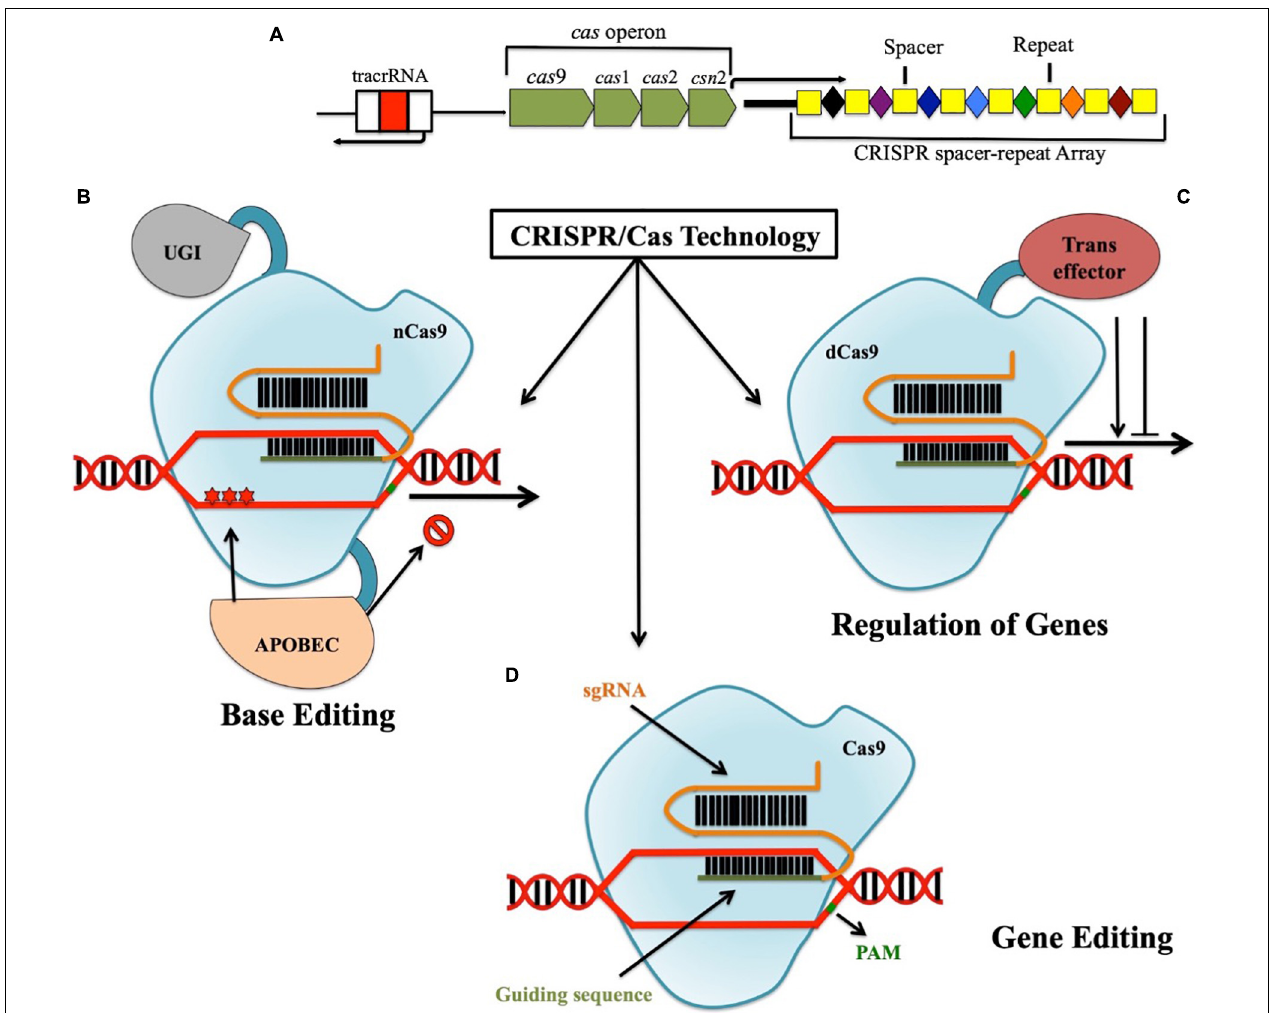
FIGURE 2 | CRISPR locus in genome comprises of CRISPR spacer-repeat array, Cas operon, and tracrRNA. Apart from being able to specifically target nucleotides in the genome (gene editing), using impaired Cas9 enzymes such as dCas9 and nickase Cas9, gene regulation and targeted base editing without double-strand breaks can also be achieved, respectively. (A) CRISPR locus in genome; (B) CRISPR/Cas9-mediated gene editing; (C) CRISPR/dCas9-mediated gene regulation; (D) CRISPR/nCas9-mediated base